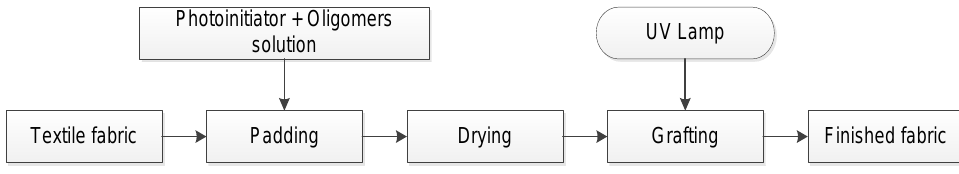
Figure 5. Flow diagram of the UV grafting process.